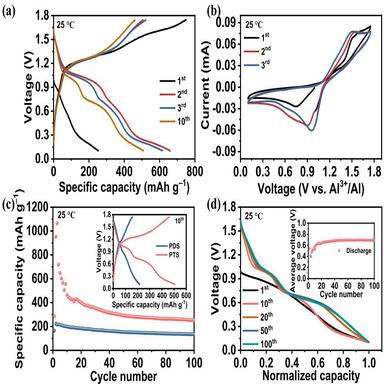
(a) Typical charge/discharge profiles of the Al||PTS battery at a current density of 100 mA g−1. (b) CV curves of the Al||PTS battery at a scanning rate of 0.1 mV s−1 in the initial three cycles. (c) Cycle performance of Al||PTS and Al||PDS batteries at 100 mA g−1. The inset shows the comparison of charge/discharge profiles of the two batteries in the 10th cycle. (d) Normalized discharge profiles of the Al||PTS battery showing the voltage evolution upon cycling. The inset shows the average voltage retention